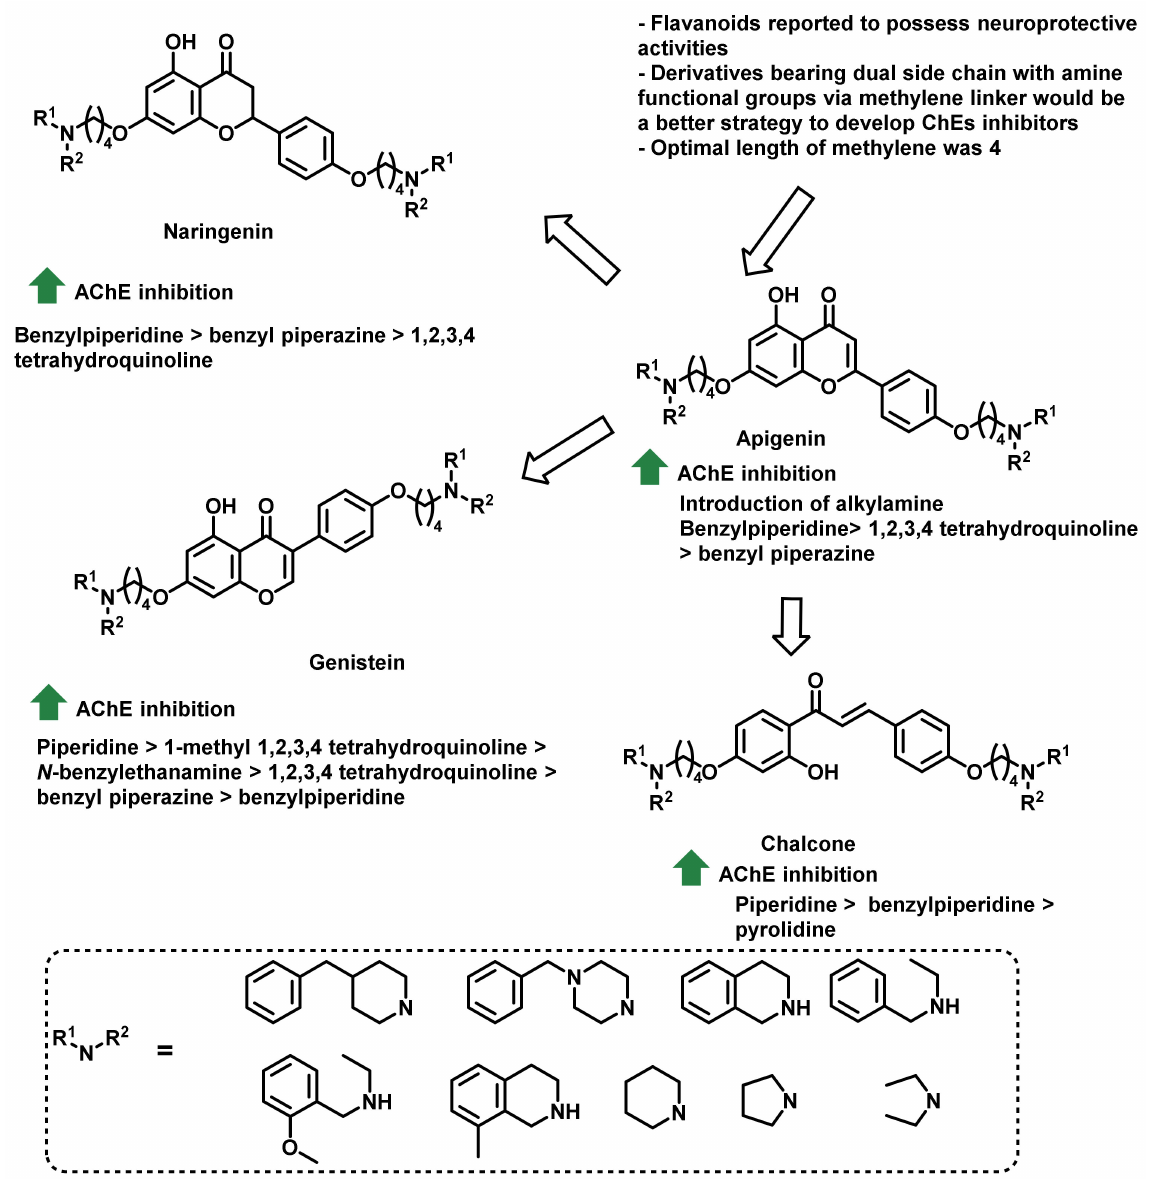
Figure 31. Flavonoid-inspired chalcone